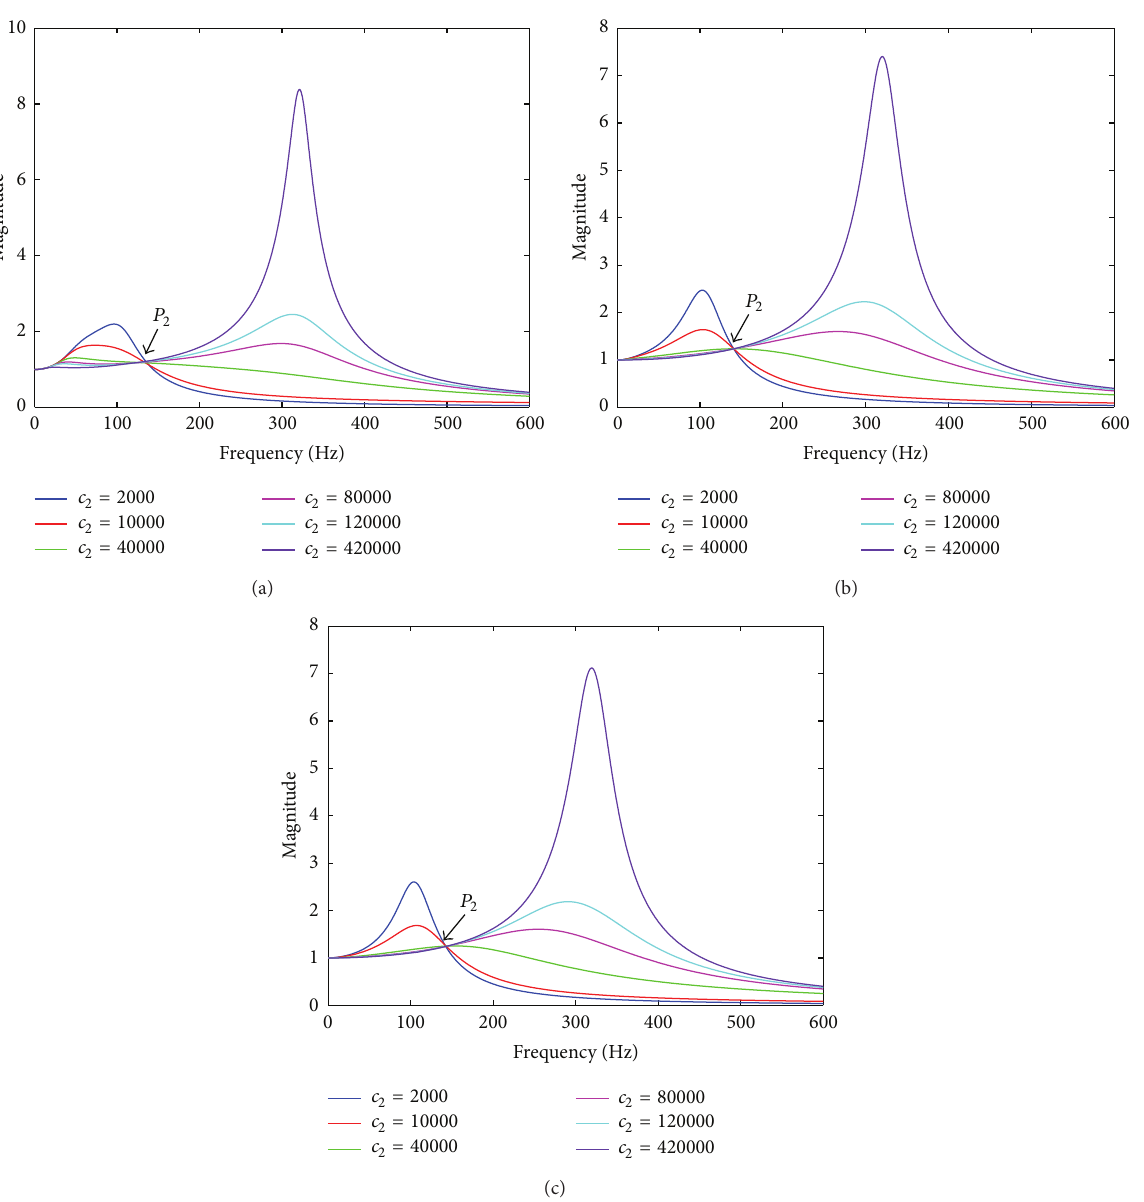
Figure 25: Absolute displacement transmissibility curves of CM under 0.76 mm FDE cases. (a) 𝑛 1 = 1.5 ; (b) 𝑛 1 = 1 ; (c) 𝑛 1 = 0.85